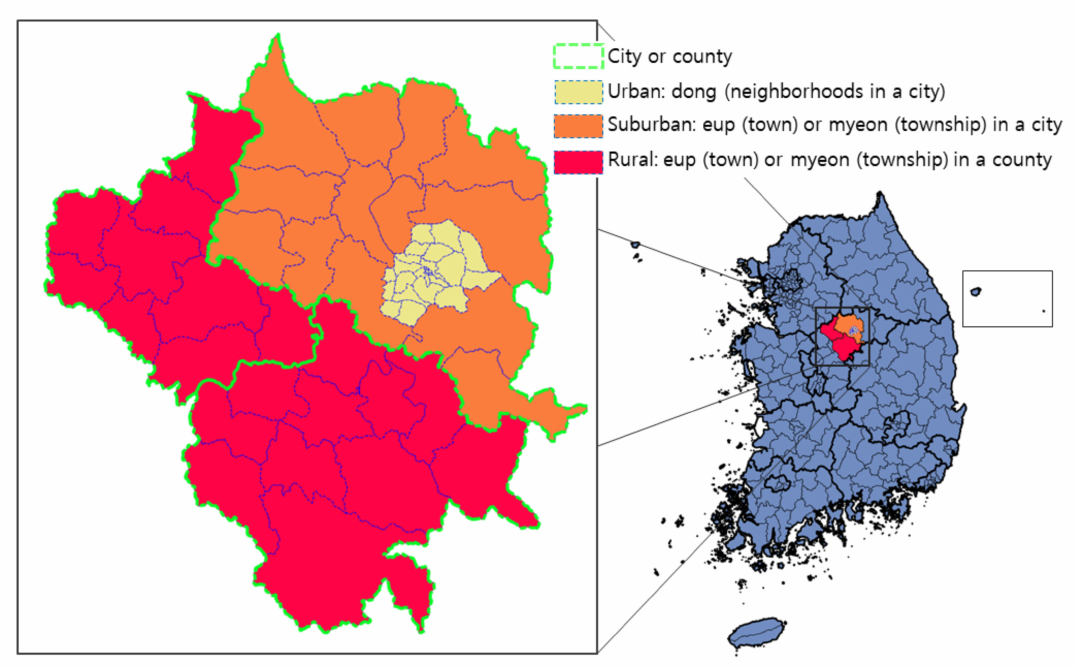
Figure 2. Concept of classifying an area as urban, suburban, or rural using sub-municipal administra- tive divisions in South Korea (created using the shapefile from